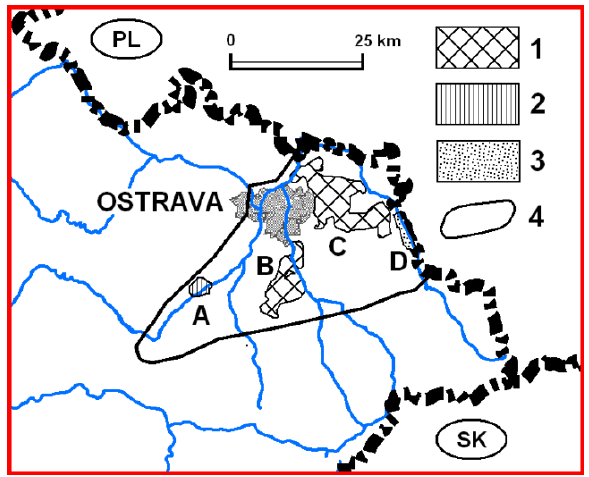
Fig. 8. Types of post-industrial landscapes in the region of Ostrava in Upper Silesian